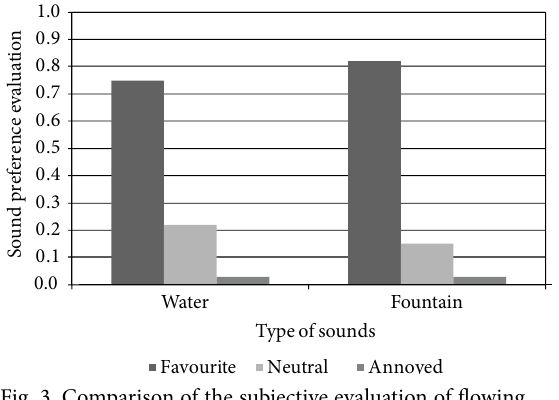
Fig. 3. Comparison of the subjective evaluation of flowing water and fountain sound